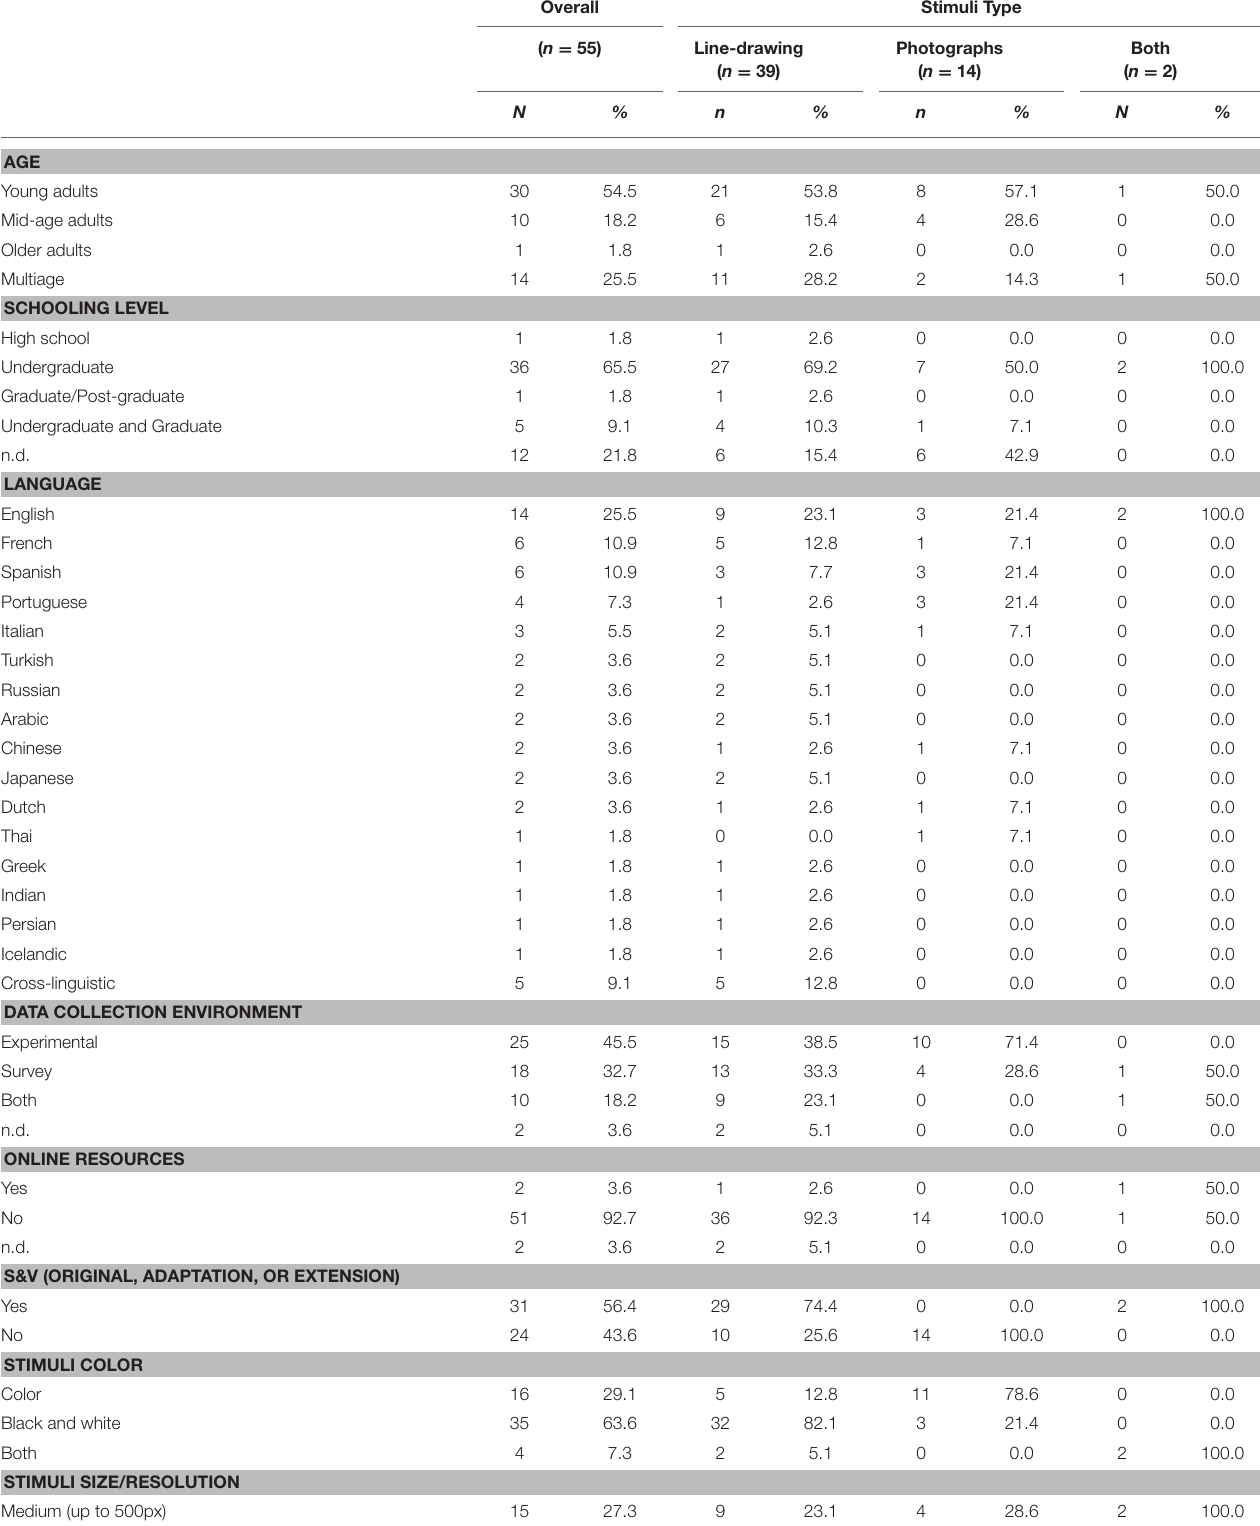
TABLE 1 | Summary table of the main characteristics of the studies sample by Stimuli Type (absolute frequencies and percentage).